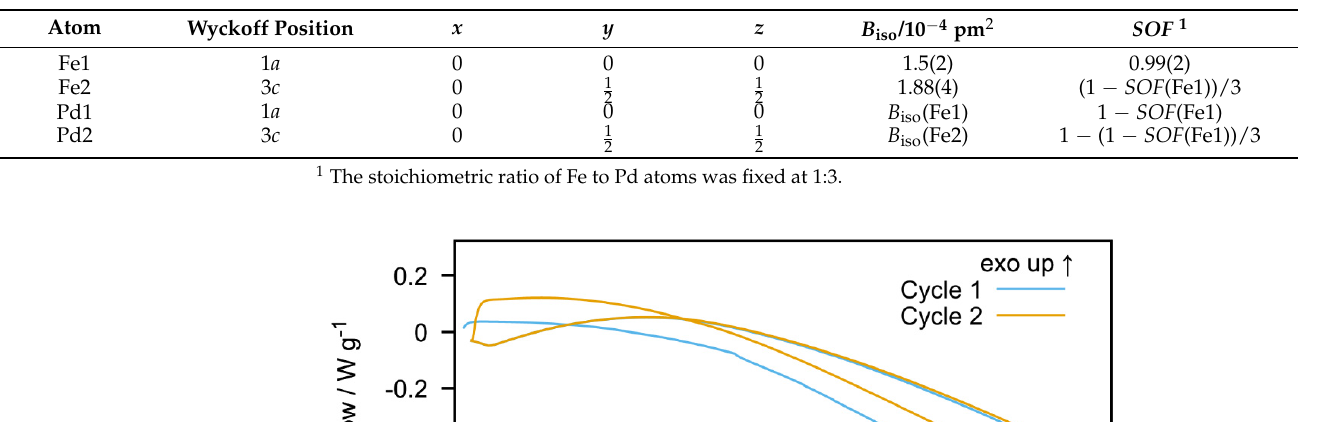
Table A2. Crystal structure parameters of FePd 3 (long-time annealed sample, Pm 3 (cid:3364) m , a = 385.412(4) pm) based on XRPD data (see Figure A2) at 296(1) K.